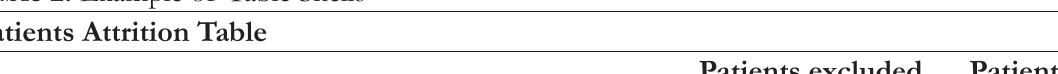
Table 2. Example of Table